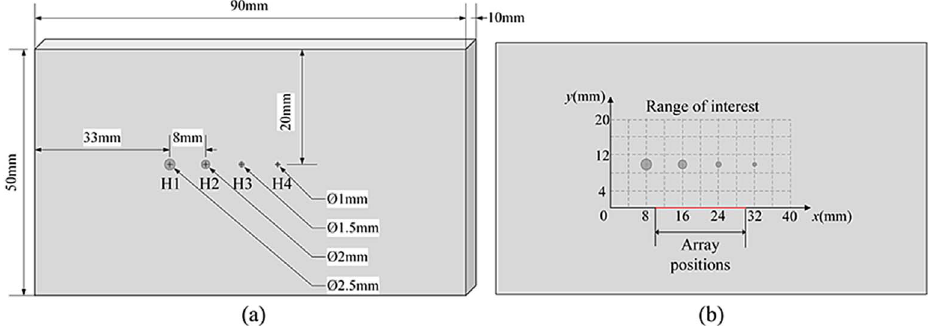
Figure 6. (a) The dimensional drawing of the aluminium block with four holes whose diameters range from 1 mm to 2.5 mm. (b) Schematic diagram with the range of interest and array